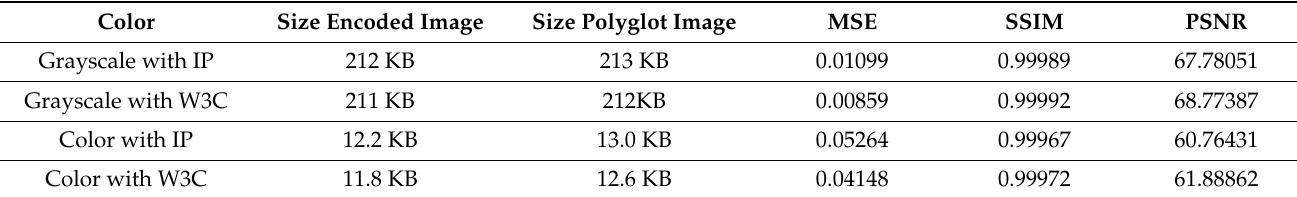
Table 15. MSE, SSIM, and PSNR were calculated between the original and encoded